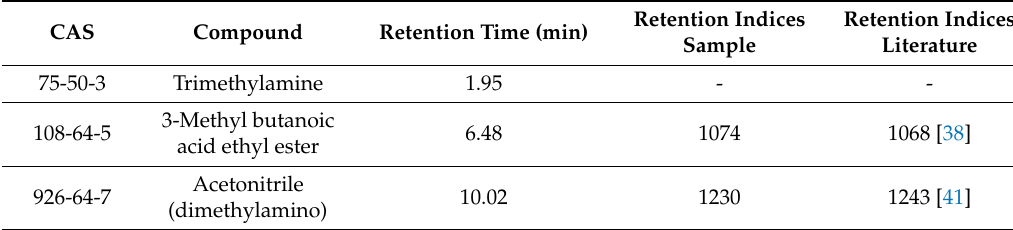
Table 6. Three compounds, previously unreported in the literature [31], identified from the headspace of alkaline treated stool